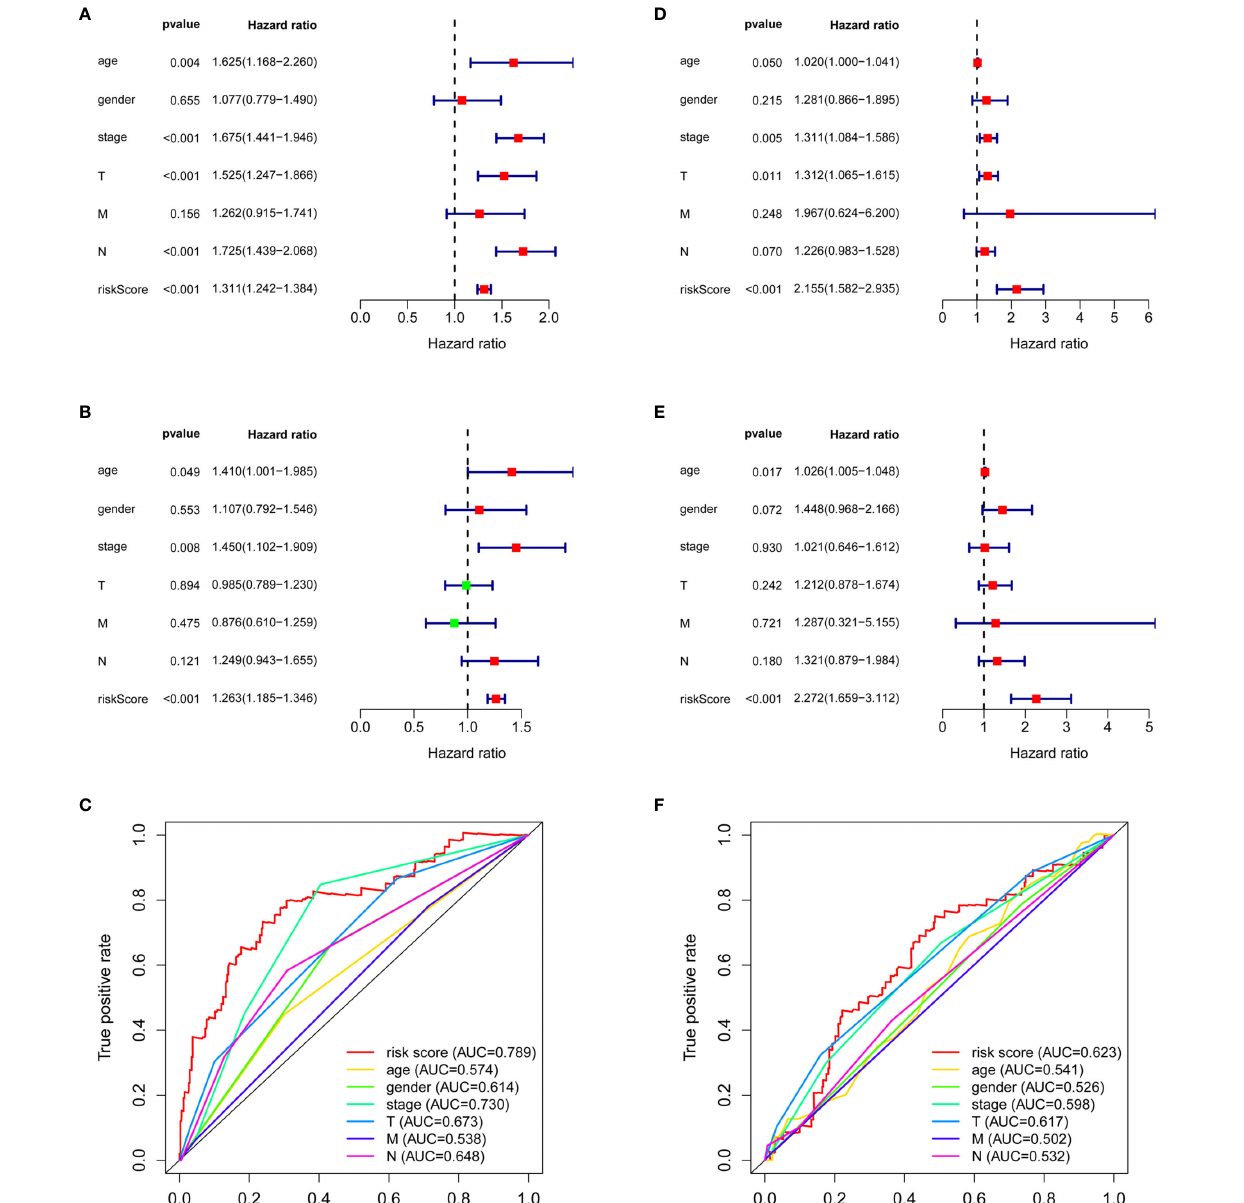
Cross table analysis indicated that more patients at stages II, III and IV were in the high-risk group in the AD cohort, while the patients in stage I were signi fi cantly more likely to be assigned to the low-risk group ( p < 0.05, Supplementary Table S3 ).